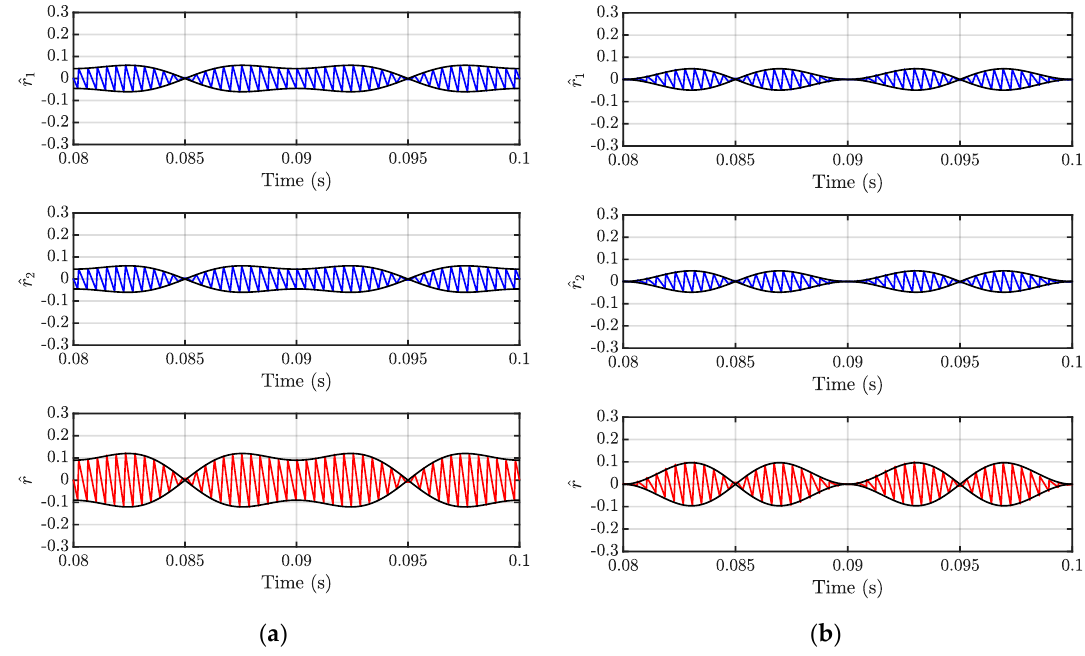
and ) (blue traces), dc-link switching 𝑟𝑟̂ 1 𝑟𝑟̂ 2